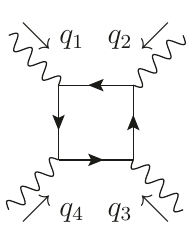
Figure 3 . The diagrams needed for the lowest order in α s OPE for the operators with field strength tensors. The diagrams are with the q legs photon or gluon and all permutations of the external 3 , q 4 legs must be taken into account.